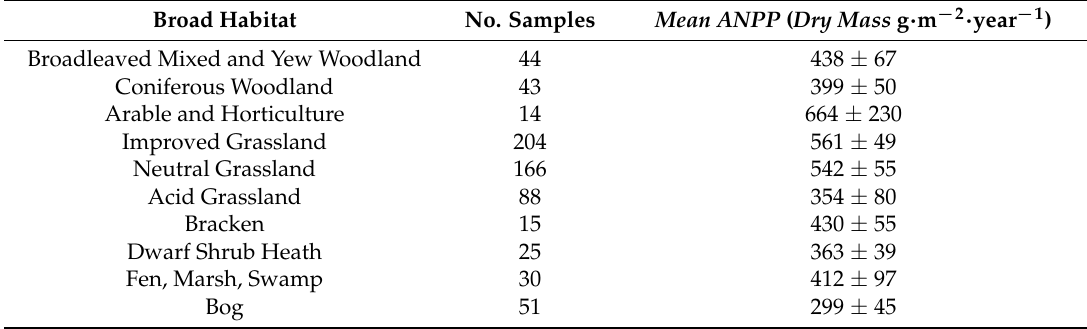
Table 2. Mean plot-level ANPP values (mean ± standard deviation) for each broad habitat type, from GMEP data for 2013 and